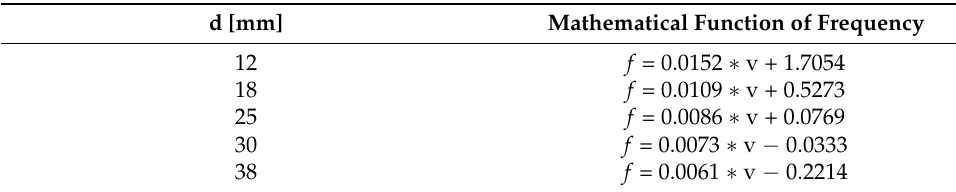
Table 3. Mathematical functions approximating the results of the experimental.